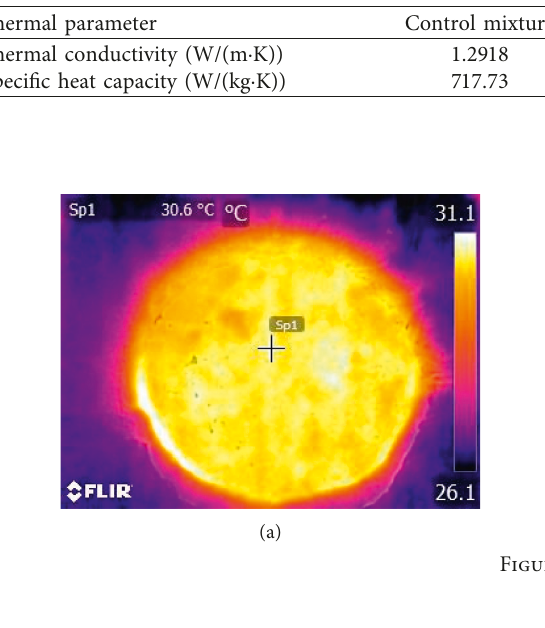
Table 5: Results of thermophysical parameters.